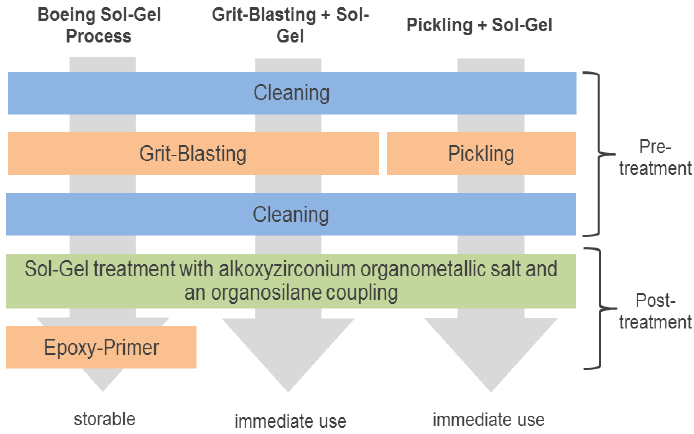
Figure 3: Schematic representation of the surface treatment